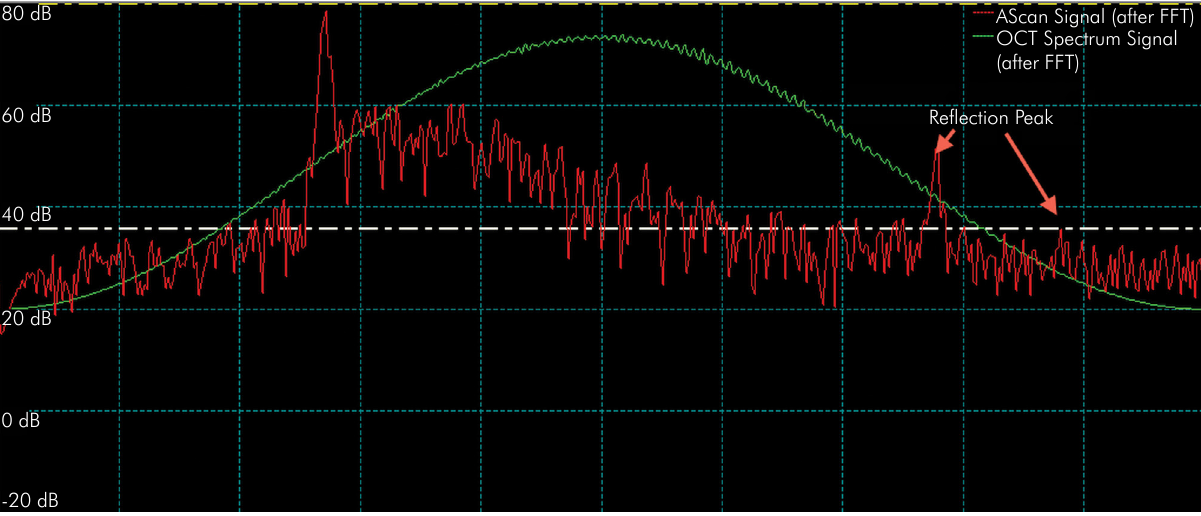
Figure 6. Fourier transform data of backscattered light from the inlay, resin cement, and tooth. A strong back reflection due to an abrupt refractive index change results in the first peak in the depth profile when the light beam encounters ceramic inlay after air. The signal sees no peaks as it travels through a medium in which there are no large indexes of refractive changes. Therefore, the signal level will rise again when light arrives at the resin cement interface. At the end of the resin cement, there will be another slight peak. The optical path length between these two peaks corresponds to the optical path length of the resin cement.